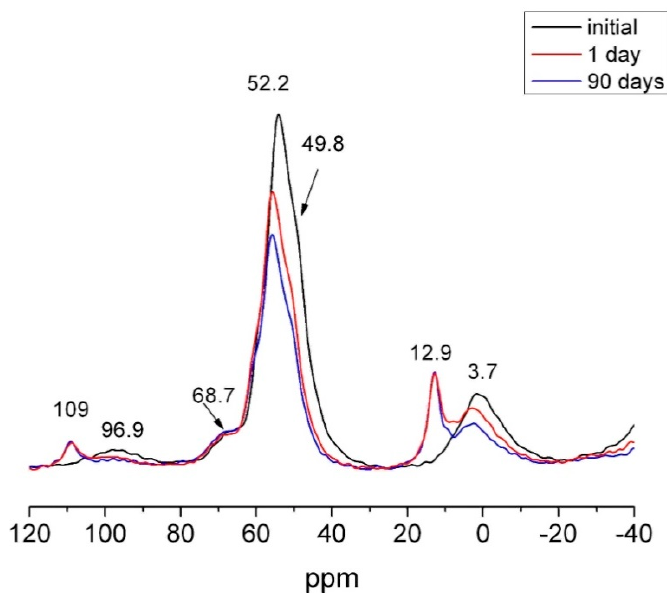
Figure 17. 27 Al NMR spectra for initial, 1 day and 90 days HsT.